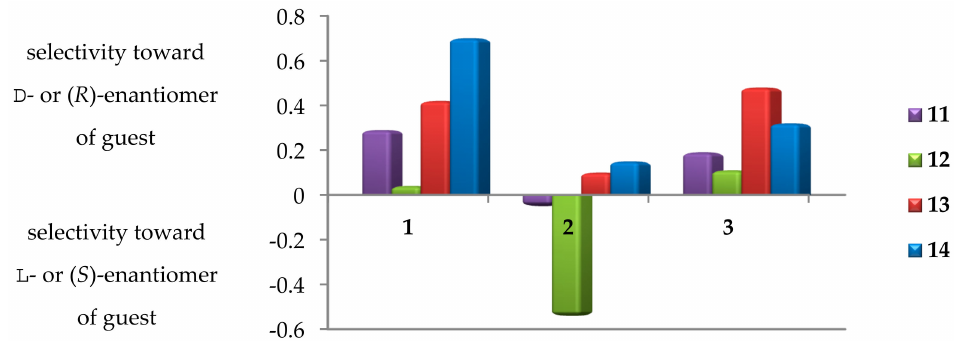
Figure 3. Plot of α rel for receptors ( R )- 1 – 3 with chiral carboxylates 11 – 14